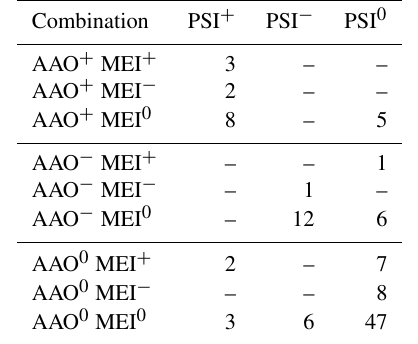
Table 4. The predominant jet regimes (PSI + indicates split jet, PSI − indicates single jet, PSI 0 indicates mixed jet regime) as counted during the 111 winter months of the 1979–2015 period, separated by occurred combinations of AAO and ENSO